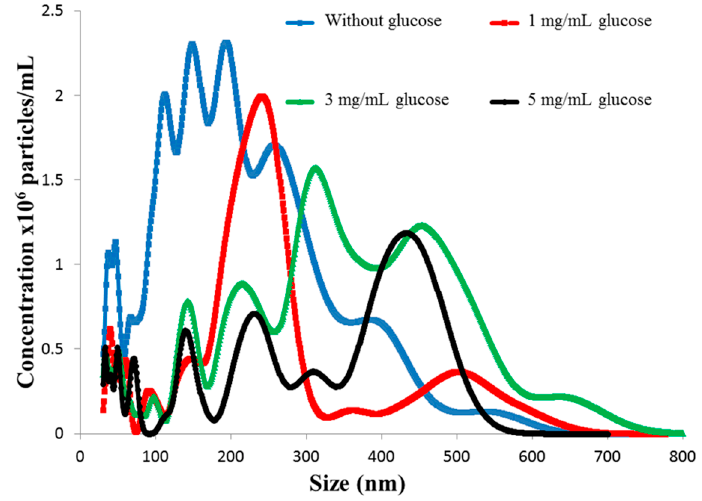
Figure 4. Particle size distribution of F3PN nanoparticles in various concentrations of glucose.